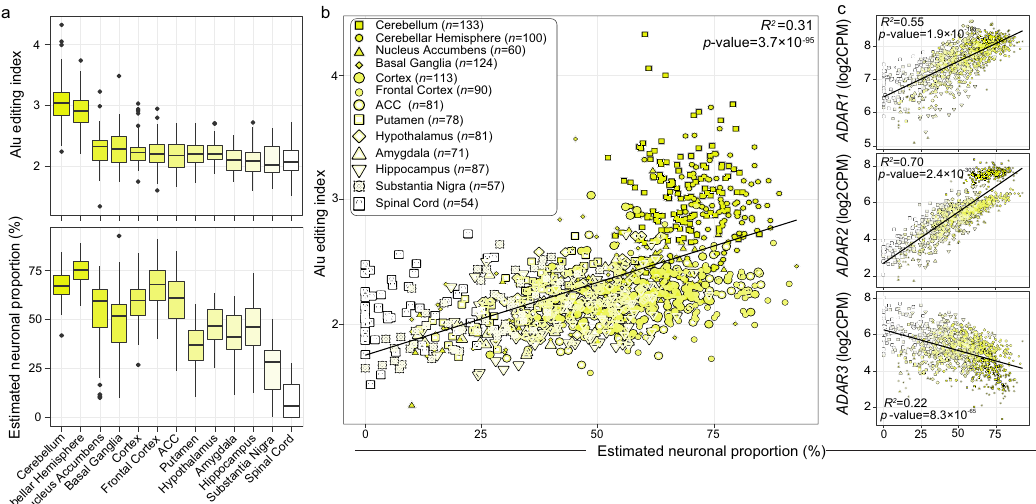
Fig. 5 Variance in global editing activity in bulk tissue explained by neuronal content. a Alu editing index (AEI) (y-axis, upper) and estimated neuronal cell type proportions (y-axis, lower) across 13 brain regions from the GTEx project (x-axis). Brain regions are ranked by the median level of the AEI. Cellular deconvolution was applied using the Darmanis et al., 2015 reference signature matrix. Box plots show the medians (horizontal lines), upper and lower quartiles (inner box edges), and 1.5 × the interquartile range (whiskers). b The amount of AEI variance (y-axis) and T. c ADAR expression explained by neuronal proportions per region was determined using a regression model across all 13 brain tissues ( ADAR1 upper, ADAR2 , middle, ADAR3 lower panel). Associations with a p value <0.05 were deemed signi fi cant. R -squared values are reported and no adjustments were made for multiple comparisons. The total number of independent biological replicates per region is depicted within panel b inset and also provided in Supplementary Data